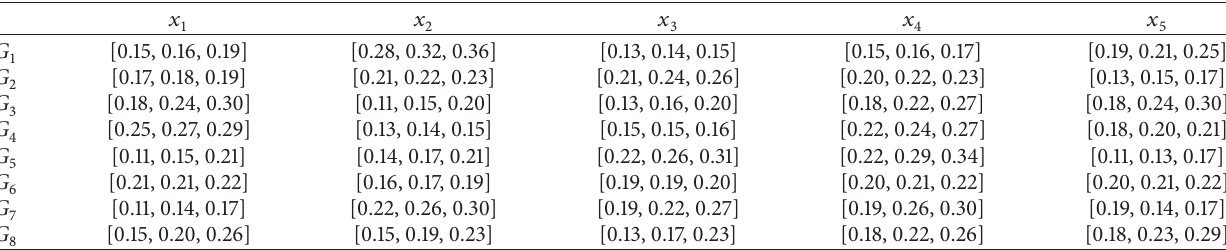
Table 5: Normalized triangular fuzzy number decision matrix 𝑅 (2) .